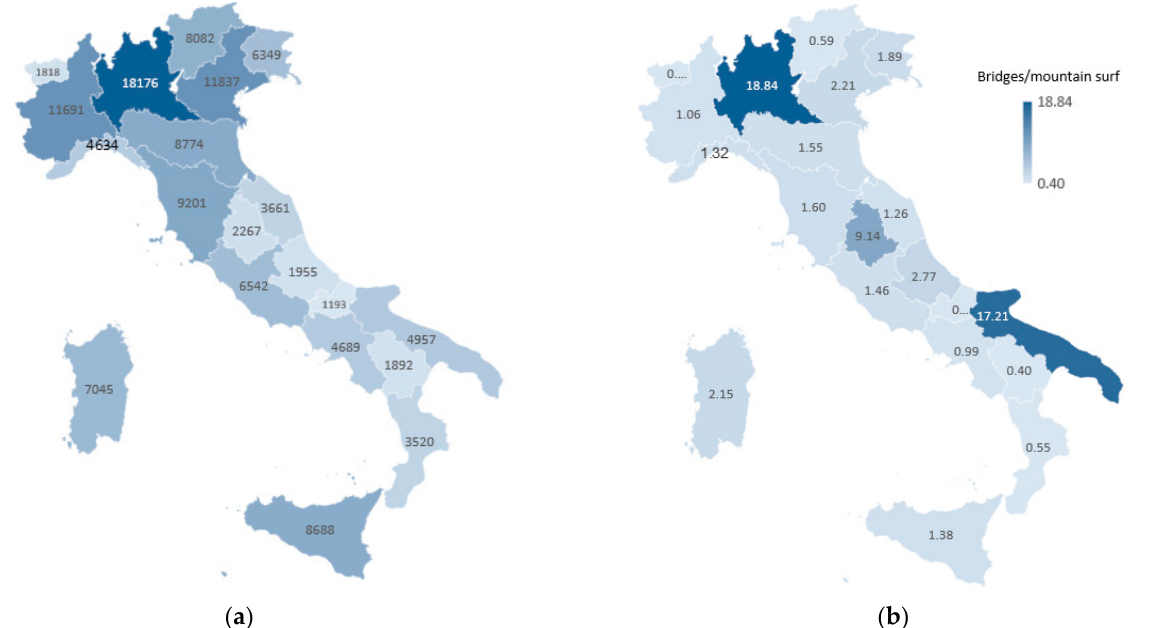
Figure 1. Distribution of Italian road bridges: ( a ) absolute number and ( b ) number of bridges per square kilometre of mountain surface.